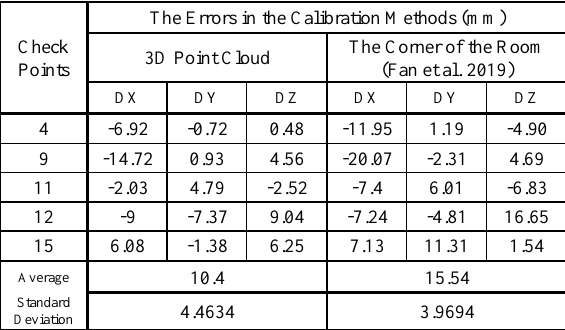
Figure 7. The error values of the check points for the calibration methods. Table 4. The Errors in the Calibration